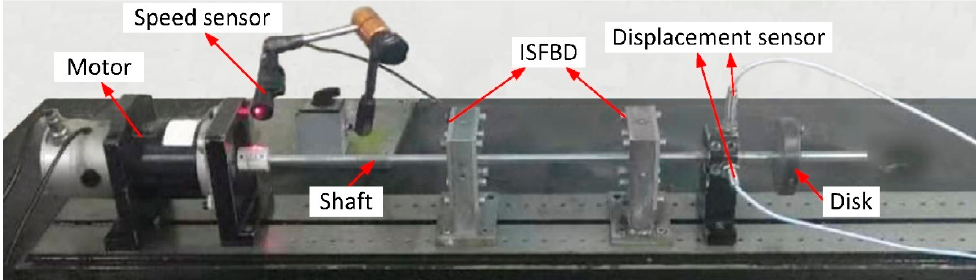
Figure 10. Diagram of the experimental platform.